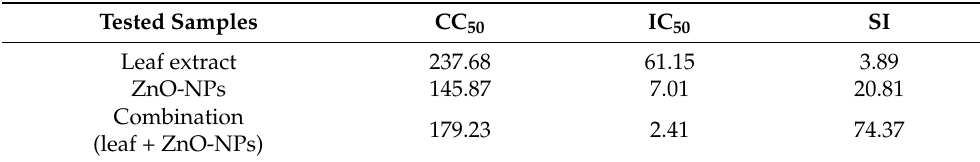
Table 3. Antiviral activity against human coronavirus (229E). Tested